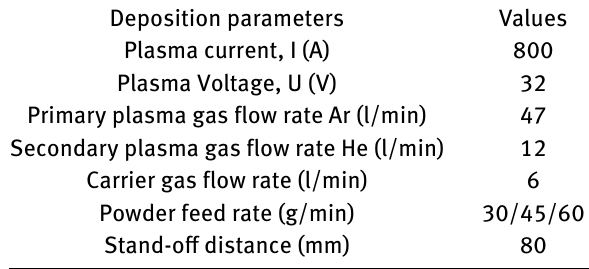
Table 1: Plasma spray parameters Deposition parameters